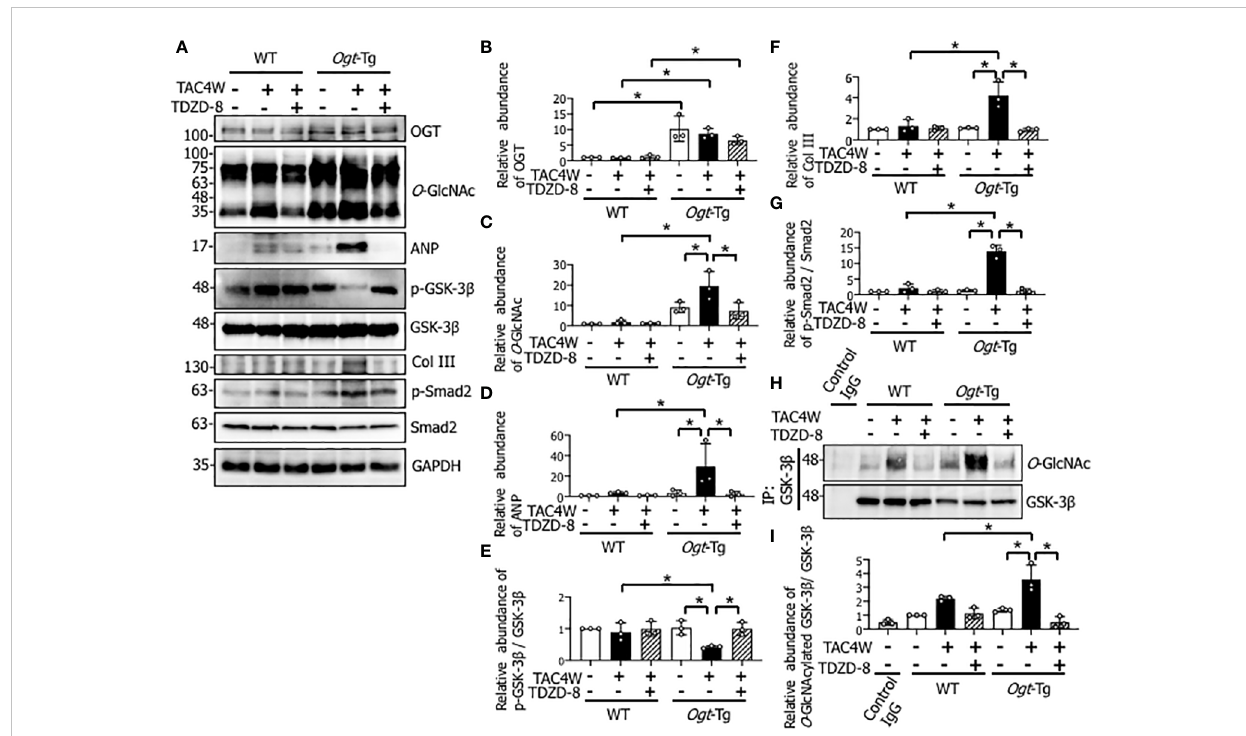
FIGURE 6 Restoration of decreased phosphorylation of GSK-3 b by the treatment of TDZD-8 in the hearts of Ogt-Tg mice after TAC4W. (A) Western blot analysis for OGT, O-GlcNAc, ANP, Col III, and phosphorylation of GSK-3 b , Smad2 in heart tissues from TAC4W-induced WT and Ogt-Tg mice with or without GSK-3 b inhibitor (TDZD-8 (10 mg/kg/day, 3 weeks, IP)) treatment. Representative data was designated. (B – G) Quanti fi cations of OGT, O- GlcNAc, ANP, Col III, and the ratios of p-GSK-3 b /GSK-3 b , p-Smad2/Smad2 expression intensity in (A) from three independent experiments using ImageJ software. The data were evaluated by two-way analysis of variance (ANOVA) followed by Tukey ’ s test. Values are shown as mean ± SD. *P<0.05. (H) Immunoprecipitation for O-GlcNAcylated GSK-3 b in heart tissues from TAC4W-induced WT and Ogt-Tg mice with or without GSK-3 b inhibitor (TDZD-8 (10 mg/kg/day, 3 weeks, IP)) treatment. Representative data was designated. (I) The intensity of each band for the O-GlcNAcylated GSK-3 b expression (n=3) was measured using ImageJ software, and evaluated by two-way analysis of variance (ANOVA) followed by Tukey ’ s test. Values are shown as mean ± SD (n=3). *P<0.05. TAC, transverse aortic constriction; ANP, atrial natriuretic peptides; Col III, collagen type